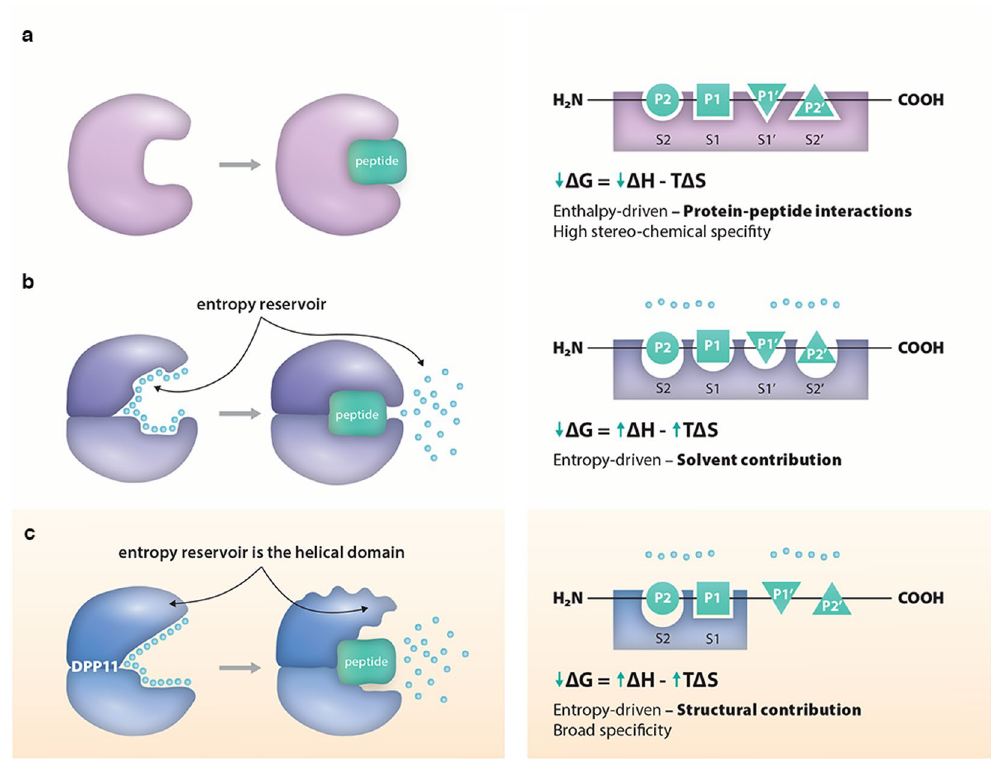
Figure 5. DPP11 conformational entropy in peptide binding. This cartoon illustrates two previously described models and DPP11 binding model reported in this work. (a) In the enthalpy-driven binding mode depicted, there are no major conformational changes and the active site is prearranged. The process is mainly governed by protein-peptide interactions, resulting in favourable enthalpy. (b) In this entropy-driven binding mode, the displacement of solvent molecules “entropy reservoir” provides the main driving-force for peptide-binding, and increases in system entropy outweighs the unfavourable enthalpy. In this case, peptide binding may be accompanied by protein conformational changes. (c) In DPP11 entropy-driven binding mode, protein conformational entropy is the main driving-force for substrate binding. De-structuring of parts of the helical domain “entropy reservoir” contributes to the increase in entropy necessary to compensate for the unfavourable